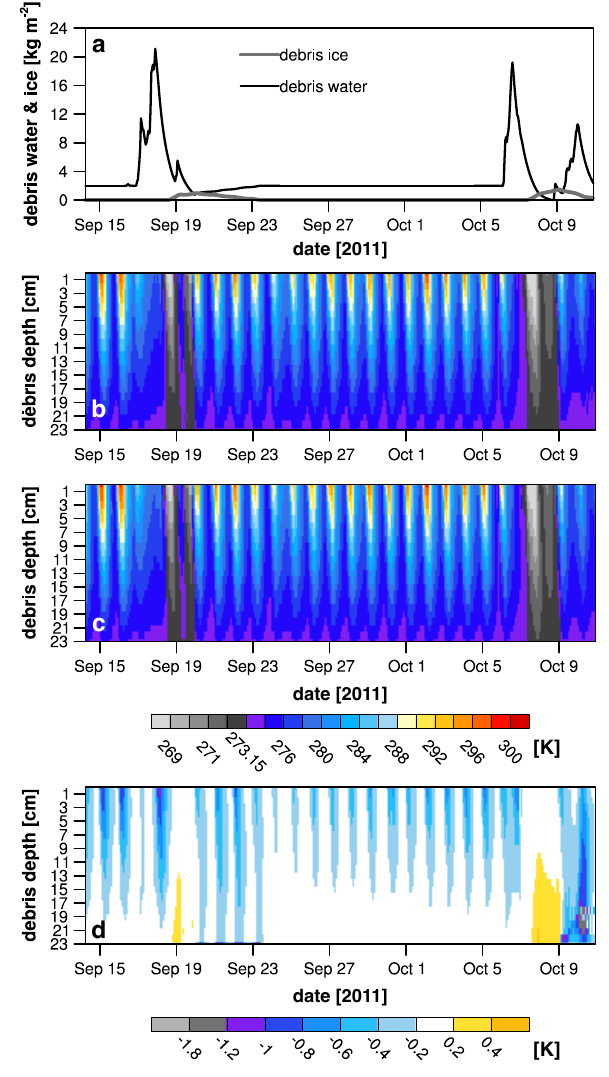
Figure 11. (a) Time series from the 2011 simulation of the debris Fig. 11. (a) Time series from the 2011 simulation of the debris water water (black line) and ice (grey line) content (kgm − 2 ). Temporal (black line) and ice (grey line) content kgm − 2 . Temporal and depth variation of the debris temperatures in (b) CMB-RES and (c) CMB- and depth variation of the debris temperatures in (b) CMB-RES DRY, and (d) the difference between the model runs (CMB-RES and (c) CMB-DRY, and (d) the difference between the model runs minus CMB-DRY). Units are K . (CMB-RES minus CMB-DRY). Units are in kelvin (K).